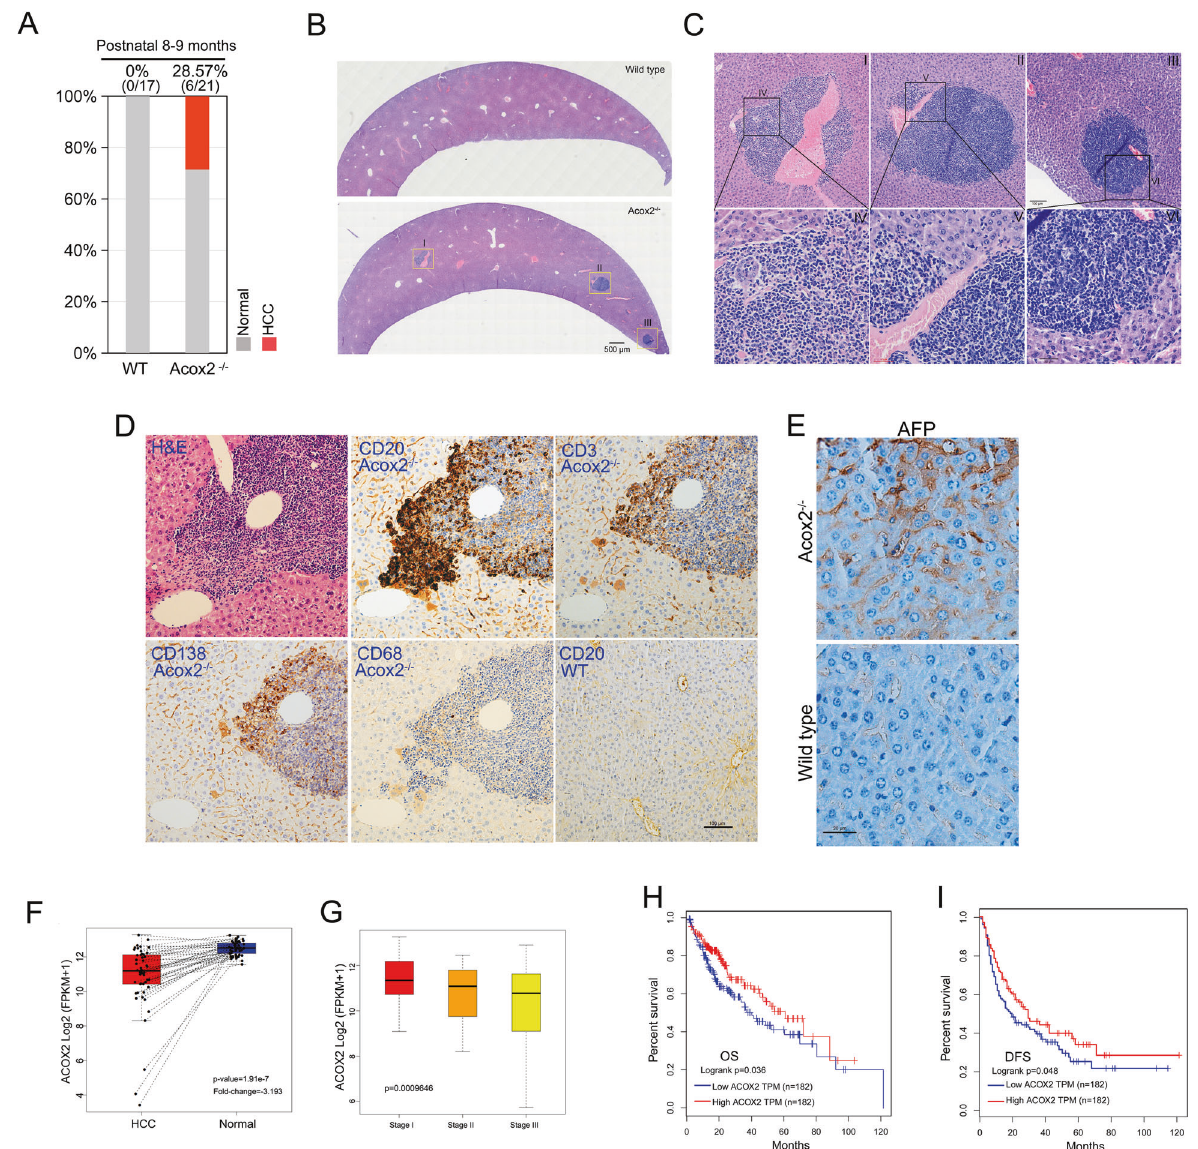
500 μ m. C Three tumor lesions (I – III) from a single cross-section of Acox2 − / − mouse liver are boxed to show the enlarged region (IV – VI) as indicated. Scale bars, 100 μ m in upper panel and 30 μ m in bottom panel. D Staining was performed using HE and immunostaining against CD3, CD20, CD68, and CD138 on liver paraf fi n sections of Acox2 − / − or WT mice. Representative images were displayed as indicated. Scale bar, 100 μ m. E Immunohistochemical staining of formalin- fi xed paraf fi n-embedded section of mouse liver tissues using AFP antibody. Representative images were displayed as indicated. Scale bar, 20 μ m. F , G ACOX2 expression level in humans is signi fi cantly downregulated in HCC than in normal liver specimens (fold-change = − 3.193; p -value = 1.91 × 10 − 7 ) ( F ) and decreases gradually in malignant stage (III) when compared with the early stage (I) ( p -value = 0.00096) ( G ) by analyzing data from TCGA portal. H , I Low ACOX2 expression in human HCC is correlated with a decrease in OS (overall survival, p -value = 0.036) ( H ) and DFS (disease free survival, p -value = 0.048) ( I ) when comparing to high ACOX2 expression as observed on analyzing data from TCGA